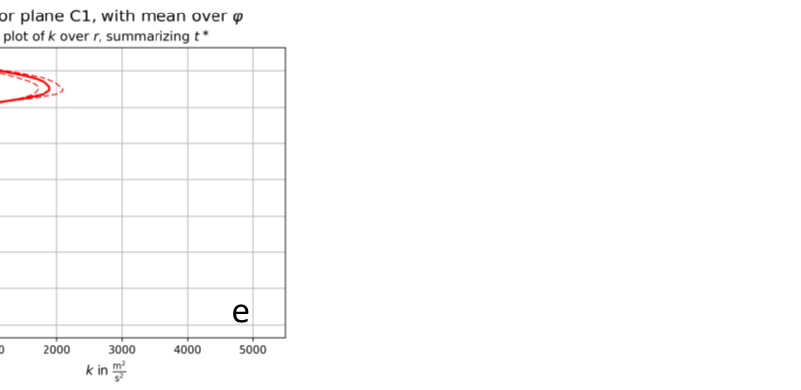
values in plane C1 at different time instants; ( e ) Time average of all mean distributions with variations